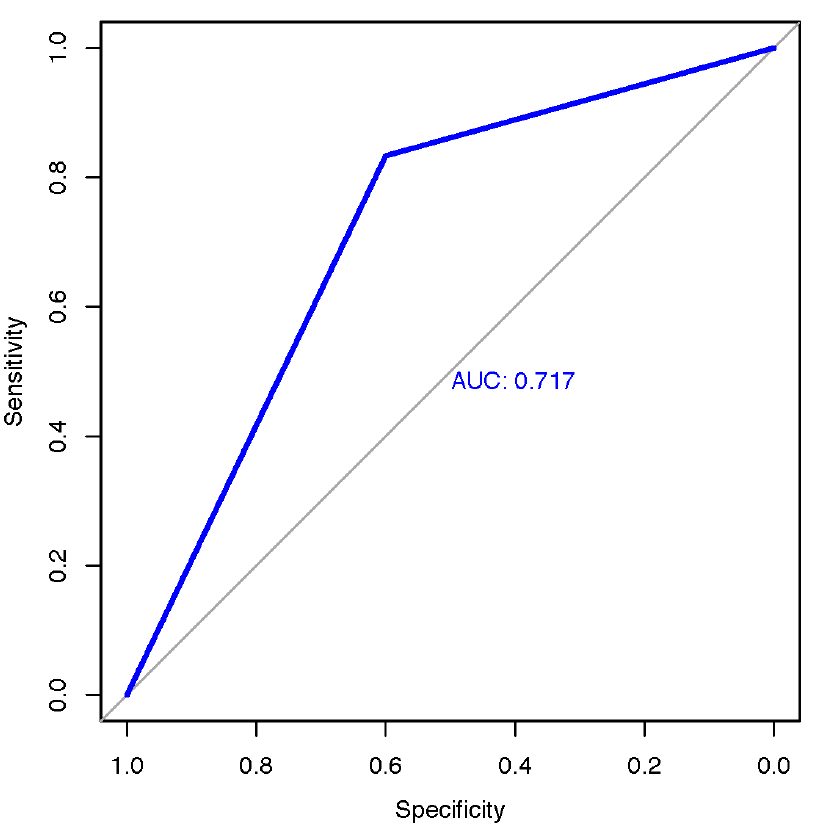
Figure 5. Correctly and falsely classified melanomas by the smartphone app SkinVision ® : ( A , B ). True-positive classified melanoma; ( C , D ). False-positive classified melanoma; ( E , F ). True-negative classified melanoma; ( G ). False-negative classified melanoma.